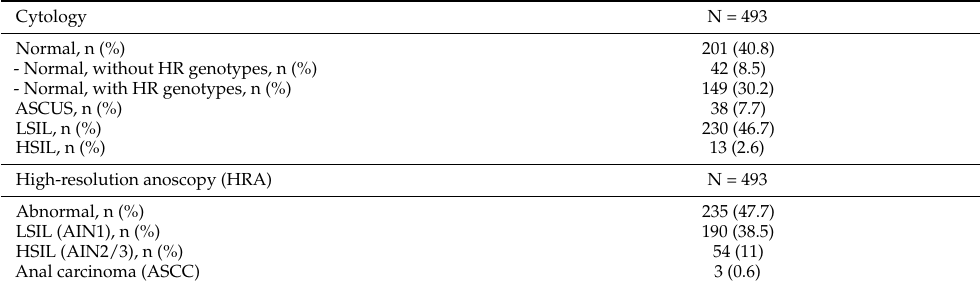
Table 4. Cytology and anoscopy results at baseline